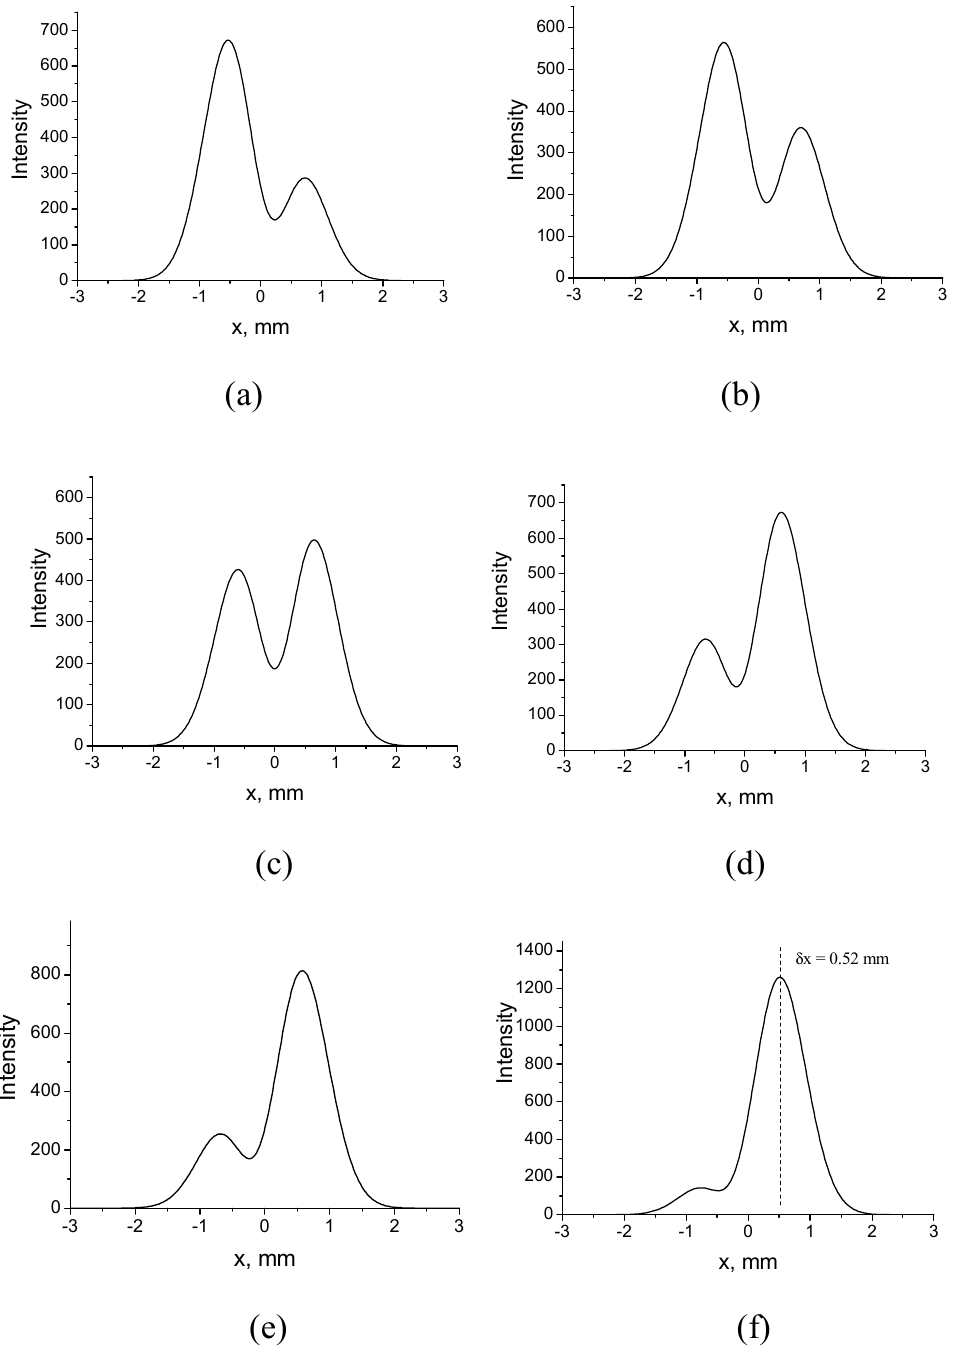
Figure 7. Calculated spatial intensity profiles of the reflected beams. z = 11 cm; incident beam FWHM = 26.64 µ m. ( a ) θ i = 33.43 ◦ ; ( b ) θ i = 33.47 ◦ ; ( c ) θ i = 33.53 ◦ ; ( d ) θ i = 33.59 ◦ ; ( e ) θ i = 33.63 ◦ ; ( f ) θ i = 33.73 ◦